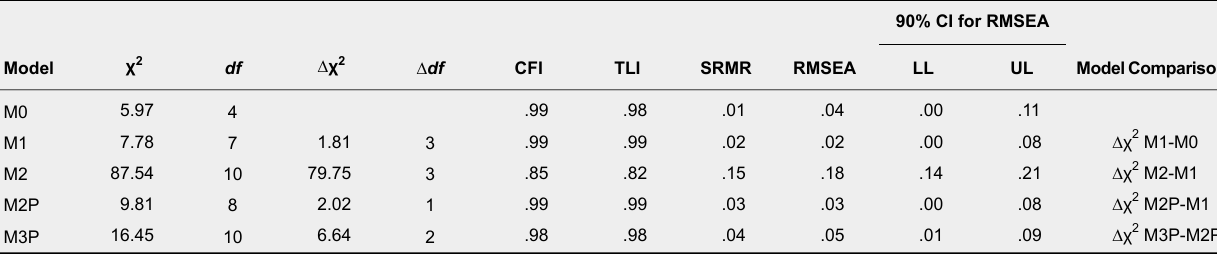
Note. M0 corresponds to the baseline model without any restricted parameter; M1 to the model testing weak invariance; M2 to the model testing strong invariance, M2P to the model testing partial strong invariance; and M3P to the model testing partial strict invariance.